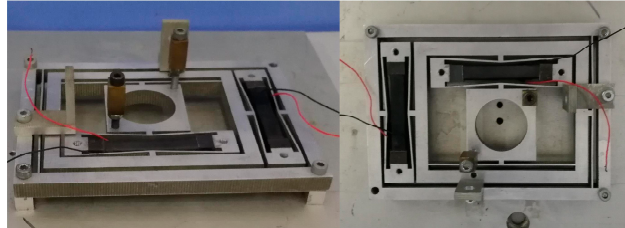
Figure 14. Measurement experiment system of the micro-positioning platform.